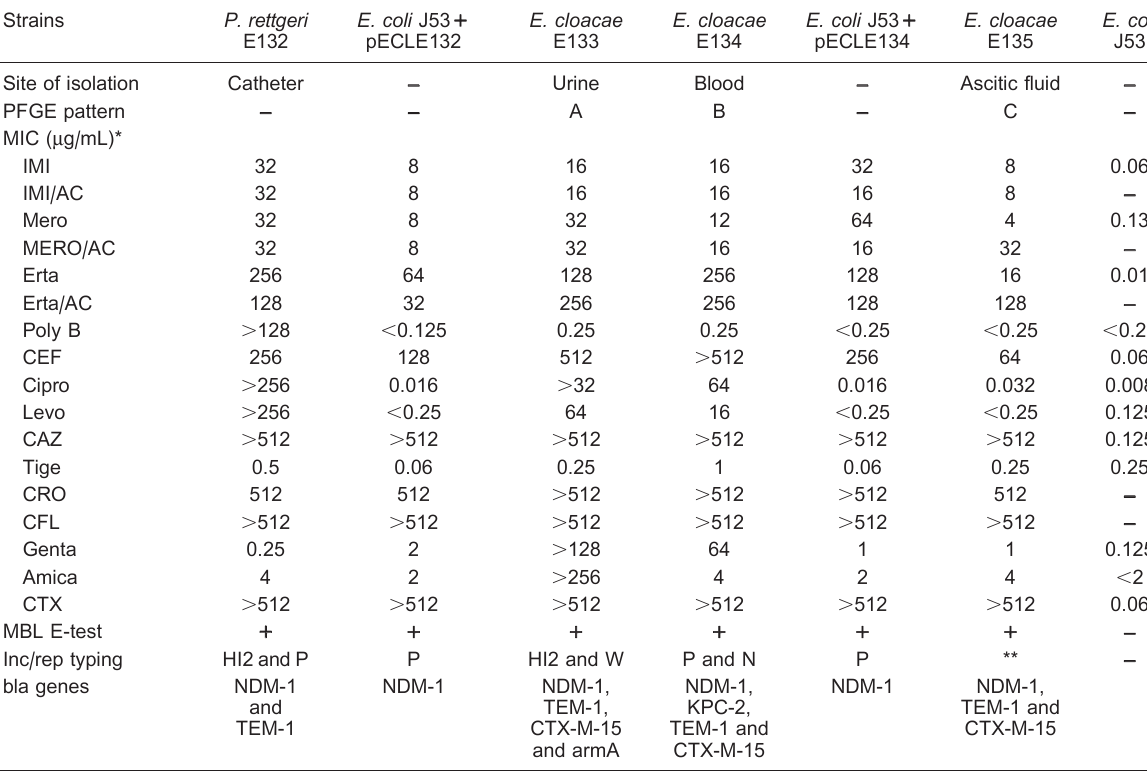
Table 1. Molecular and phenotypic characterization of NDM-1-producing isolates in Rio de Janeiro, Brazil.